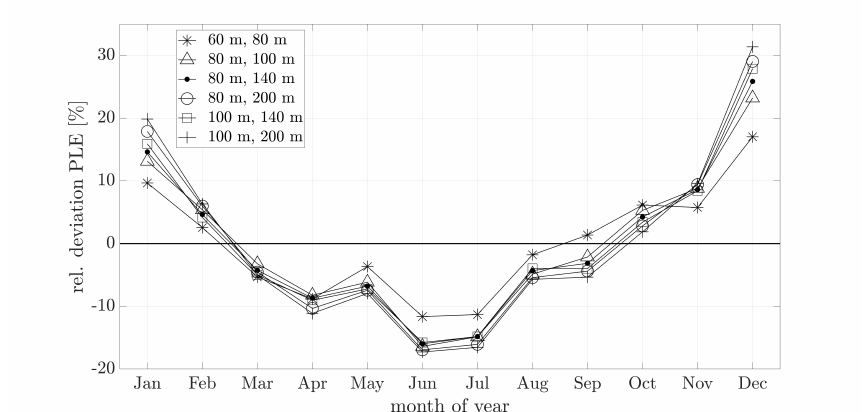
Figure 4. Relative deviation of monthly power law exponents from the yearly mean (based on monthly mean wind speeds), shown for different height ranges. The results from all measurement sites are averaged arithmetically yielding one curve per height combination.